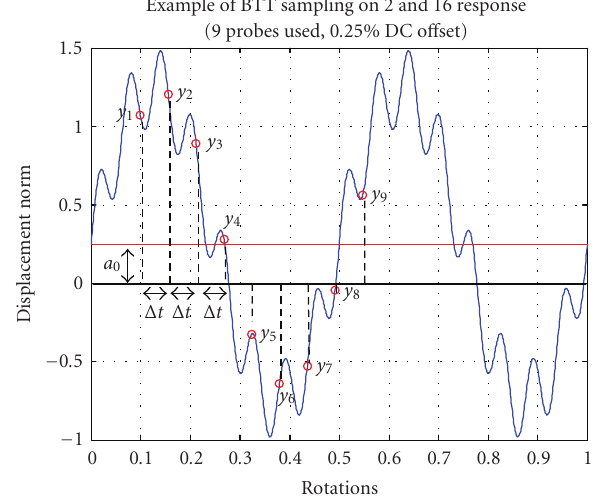
Figure 1: Relationship of sampling points to data